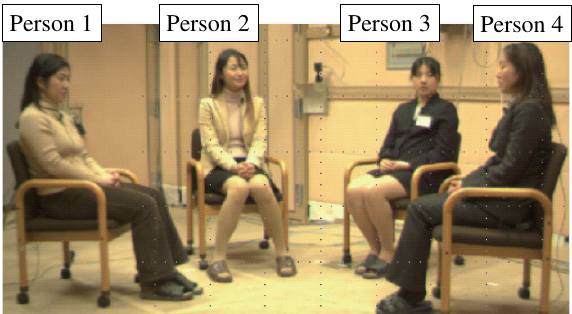
Figure 1. One scene of four-person conversation conducted for data collecting. Participants are Person 1, Person 2, Person 3 and Person 4 from the